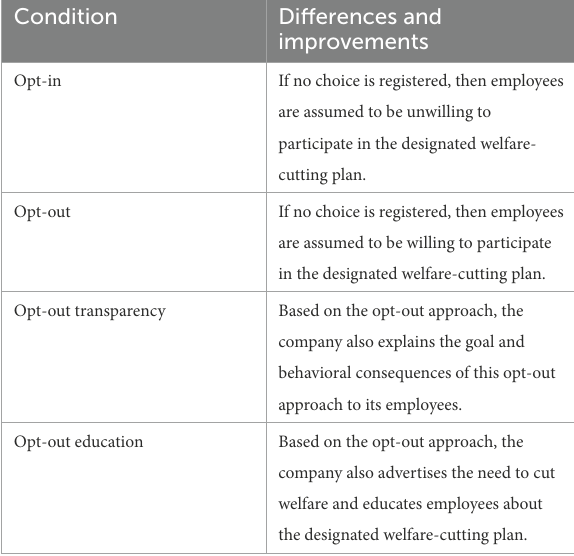
TABLE 3 Differences across opt-in condition, opt-out condition, and opt-out